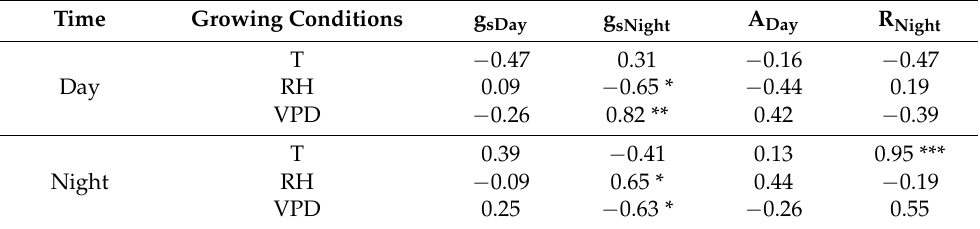
Table 7. Pearson correlation coefficients for correlations between day and night growing conditions and stomatal conductance (g s ) during day and night and assimilation (A) and respiration during the night (R), respectively, including all treatments. ***, **, *: significant at p < 0.001, p < 0.01, p < 0.05, respectively. T: temperature, RH: relative air humidity, VPD: vapor pressure deficit. Time Growing Conditions g sDay g sNight A Day R Night T −